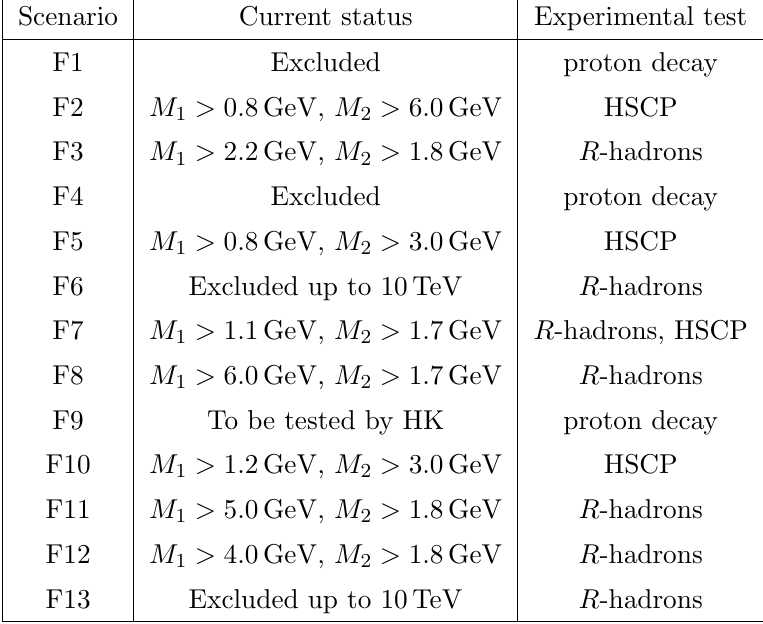
Table 6. Summary of current experimental status of the successful PGU